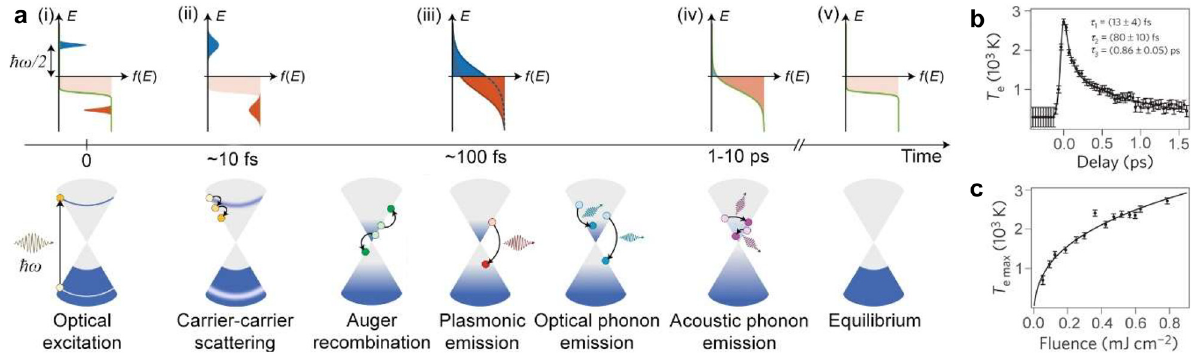
Figure 2: Hot carrier dynamics in graphene. (a)(i)InterbandcarriertransitionuponopticalexcitationandthecorrespondingFermi – Diracdistributionofcarriers.(ii)Carrier – carrierscattering at a femtosecond timescale. (iii) A quasi-equilibrium state of carriers (electron and holes exhibit different temperatures). (iv) Interband ther- malized carriers transition at a picosecond timescale, forming a single Fermi – Dirac distribution. (v) Thermal equilibrium of hot carriers with the lattice. (b) The variation of the electronic temperature with delay time. (c) The maximum electronic temperature as a function of fluence. Panel (a) adapted from [37], Panel (b) and (c) adapted from